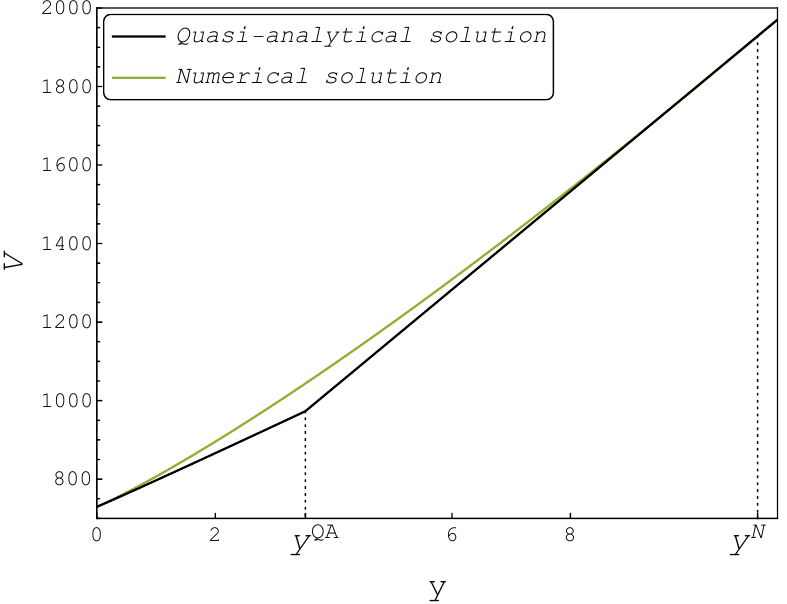
Figure 3. The numerical threshold boundary for the following set of parameter values: x = 40.52, σ 1 = 0.2, σ 2 = 0.6, α 1 = 0.02, α 2 = 0.02, r = 0.1, ρ = 0, Q 1 = 5, Q 2 = 10, I = 2000 and different values of y